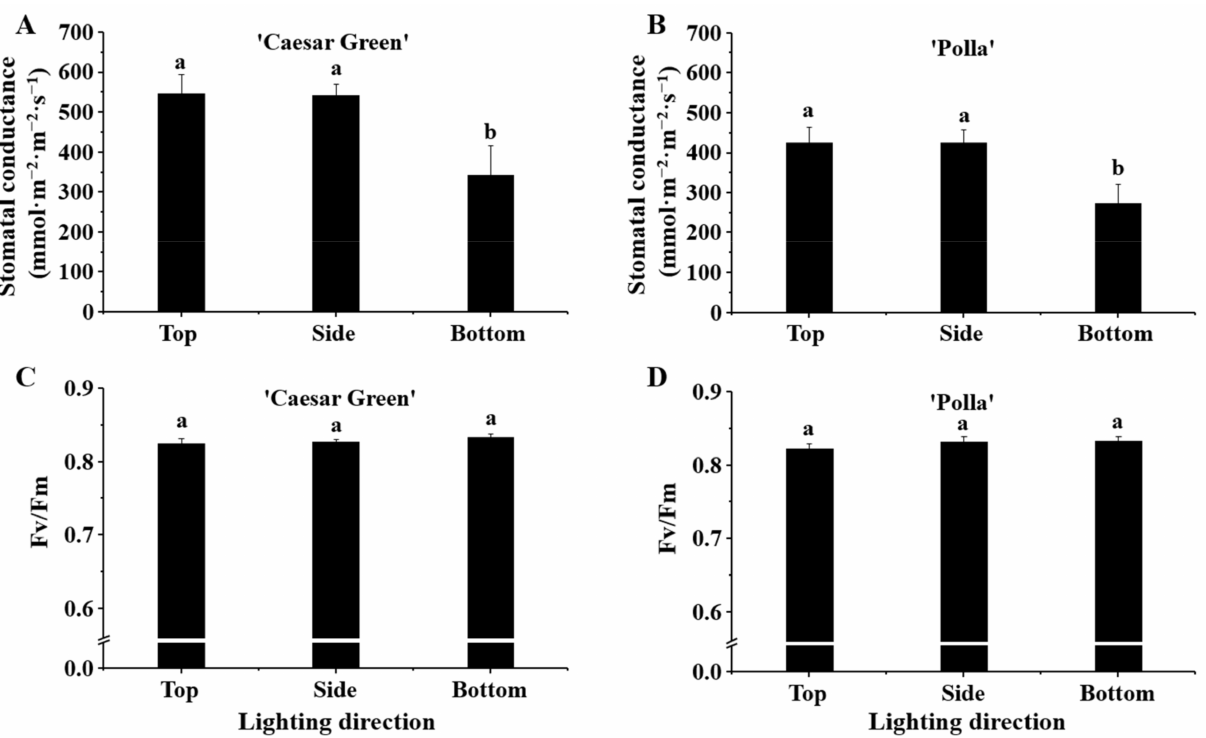
Figure 4. The effects of the lighting direction on the stomatal conductance and Fv/Fm of two lettuce cultivars Caesar Green ( A , B ) and Polla ( C , D ). Vertical bars indicate the means ± stand error ( n = 3). Different small letters indicate the significant separation within treatments by the Duncan’s multiple range test at p ≤ 0.05.